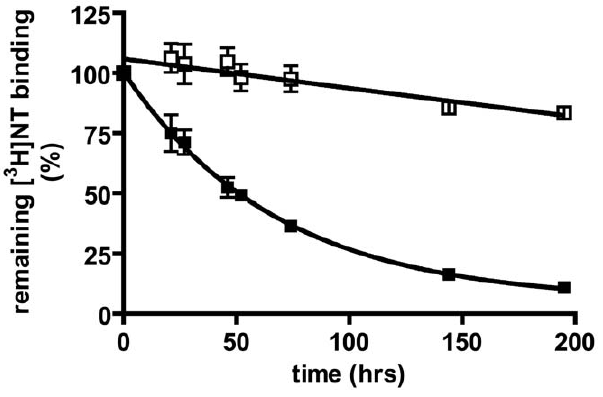
Figure 2. Stability of NTS1 in NT70 buffer with and without agonist. Receptors were incubated with [ 3 H]NT (open squares) or kept in NT70 buffer without agonist (filled squares) at 4 u C. [ 3 H]NT binding was determined at the indicated time points. The data shown are from 2 independent experiments.